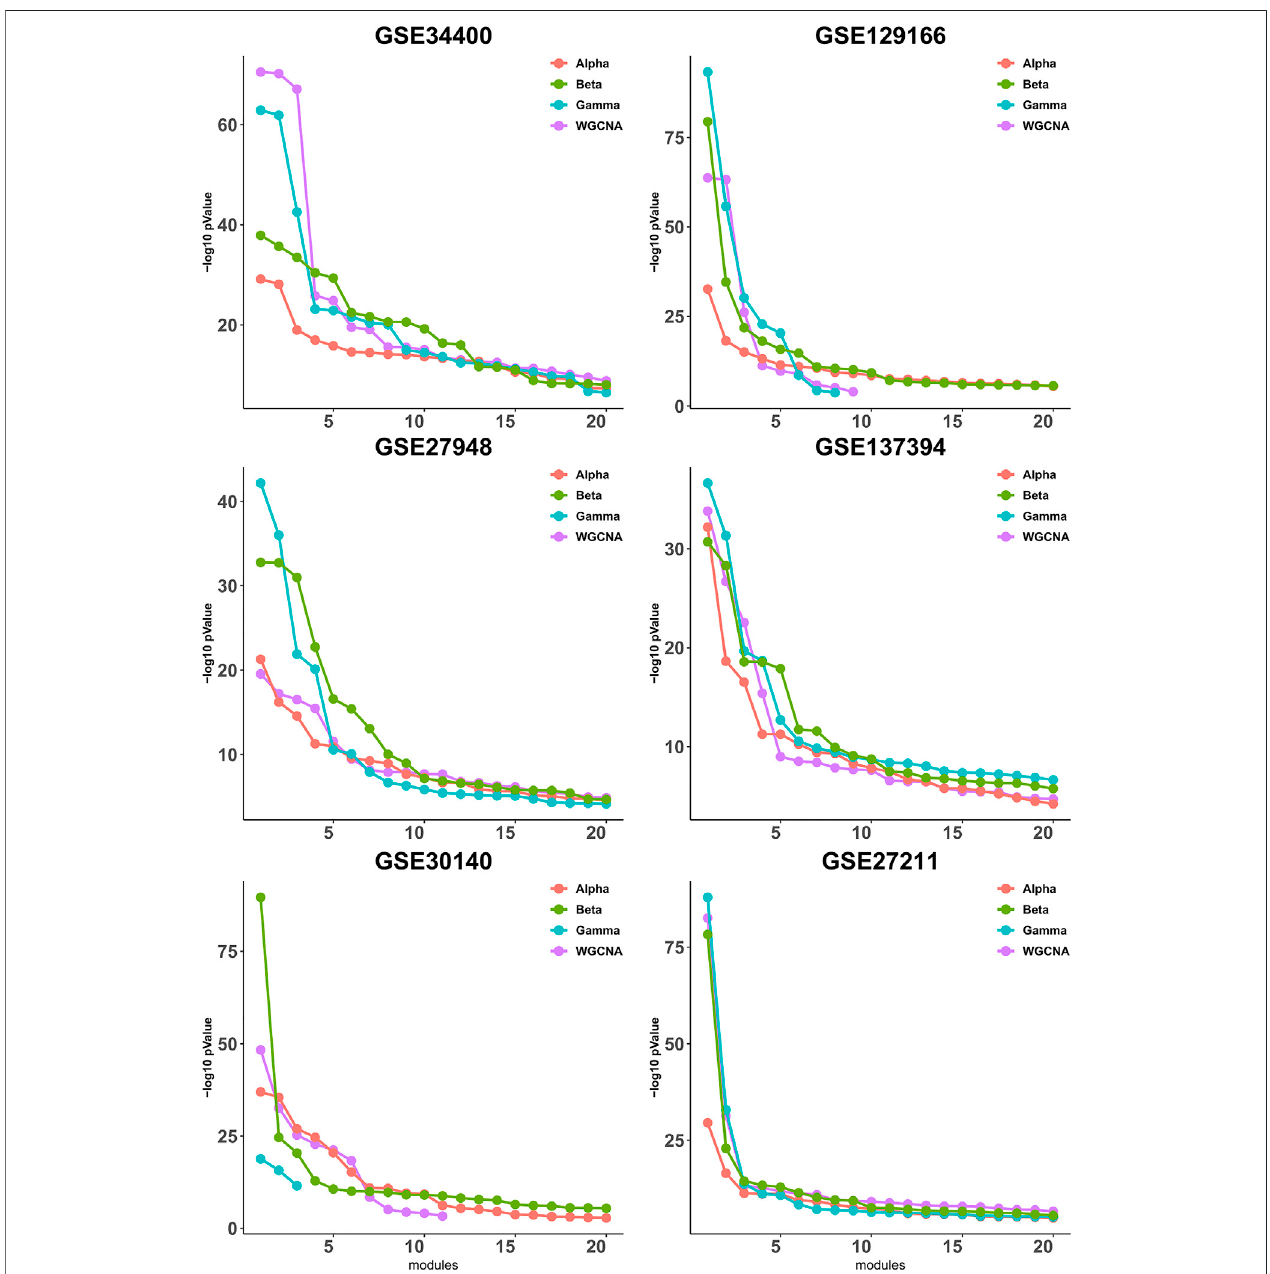
FIGURE 2 | Gene ontology enrichmentanalysis ofclusters produced by Alpha, Beta, Gamma with WGCNA in six empirical data sets. For each data set the sorted quality values (def. 6) of the modules are plotted. The x -axis and y -axis indicate the module indices and the module quality respectively.